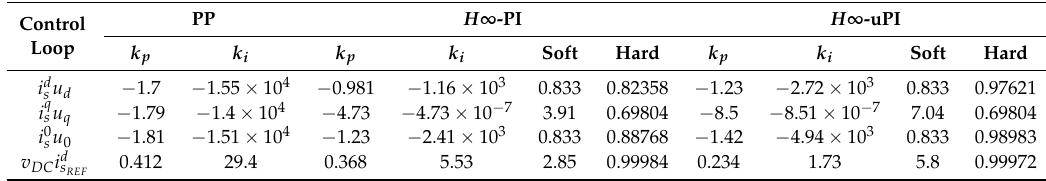
Table 2. Summary of the PI controller parameters.